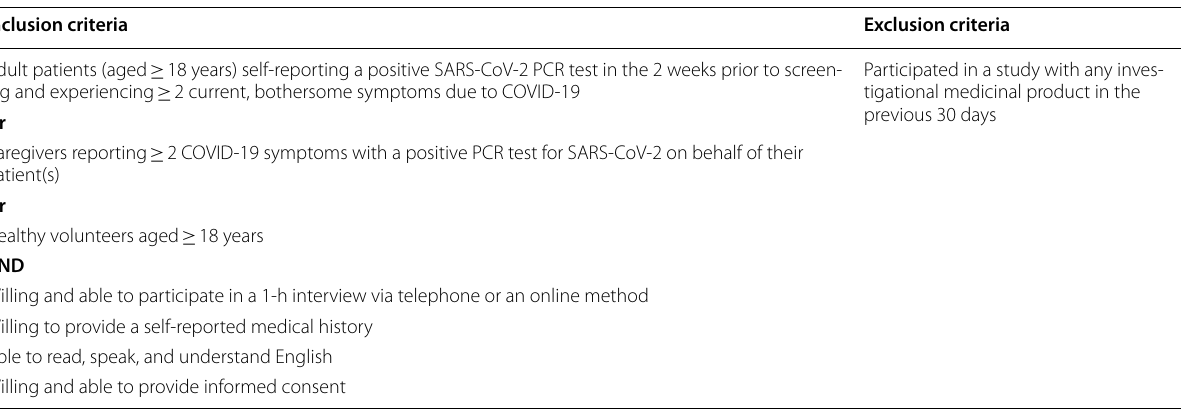
Table 1 Patient, caregiver, and healthy volunteer inclusion and exclusion criteria